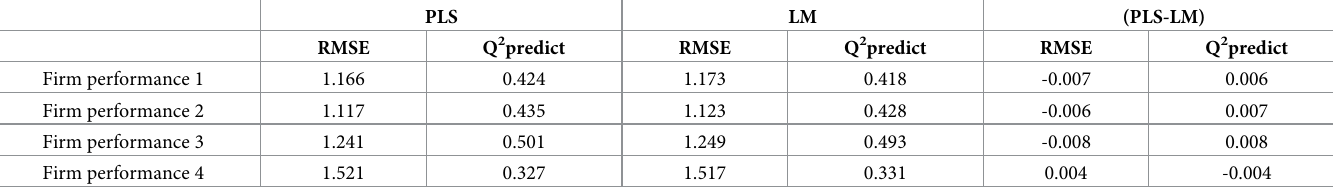
Table 5. PLSpredict assessment PLS vs. LM.